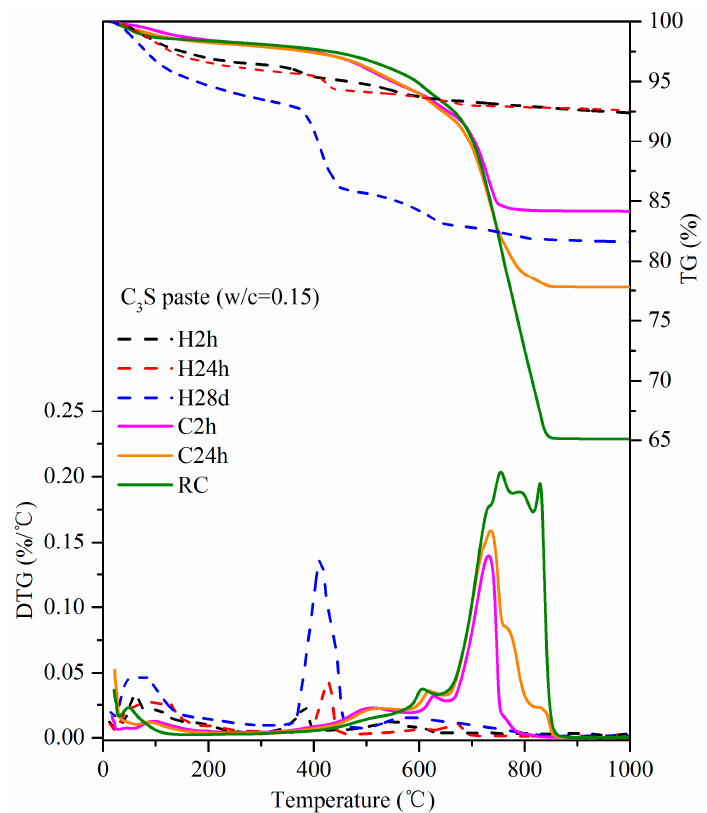
Figure 9. Thermogravimetric analysis–derivative thermogravimetric analysis (TG-DTG) curves of carbonation and hydration samples.